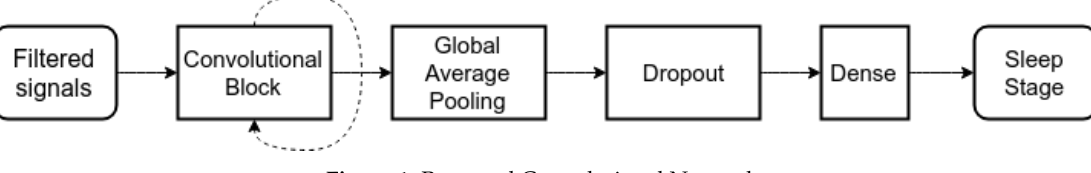
Figure 1. Proposed Convolutional Network.